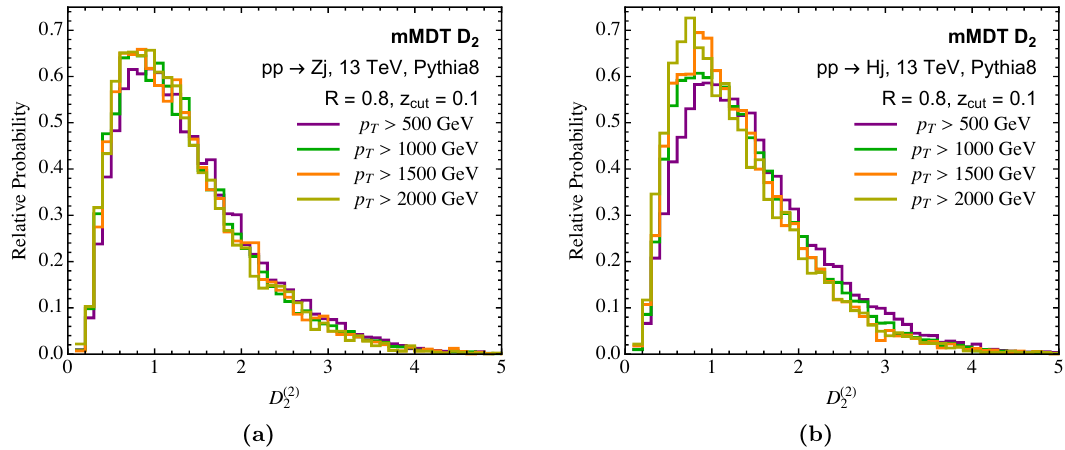
Figure 17. Distributions of D (2) measured on mMDT groomed QCD jets with z cut = 0 : 1 from 2 the processes pp Zj (left) and pp Hj (right) at the 13 TeV LHC. The groomed jet mass is ! ! restricted to lie in the range 80 GeV < m J < 100 GeV. Various p T cuts are shown, with the jet radius (cid:12)xed to R = 0 : 8.